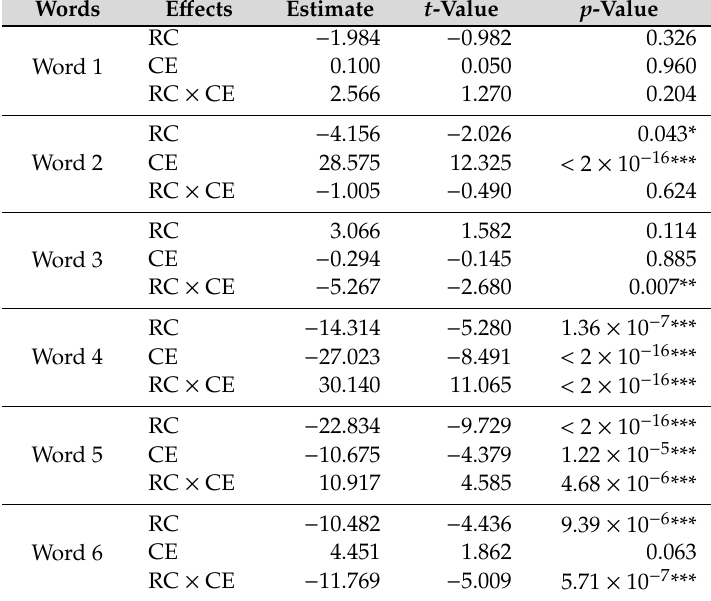
Table 3. The parameter estimates, t -values, and approximate p -values of the e ff ects from Experiment 1. Words E ff ects Estimate t -Value p